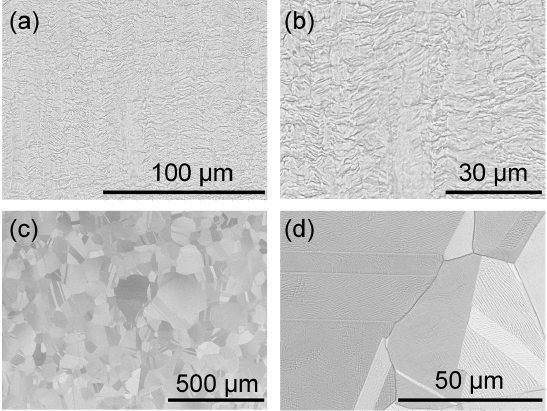
Figure 2. Scanning electron microscopy images of two types of copper foil ( a , b ) without graphene and ( c , d ) with graphene on the surface, respectively.